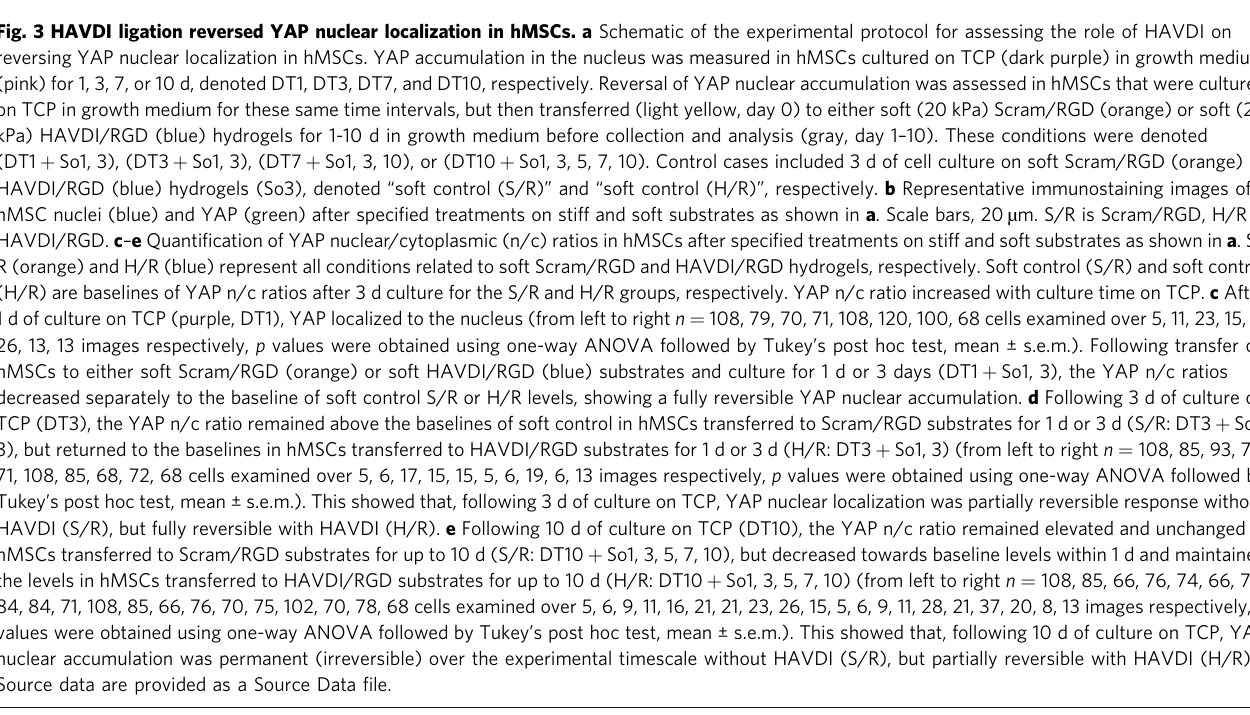
(cid:1) E (Fig. 5b). The different k relationships on Scram/RGD on sub and HAVDI/RGD hydrogels resulted in double sigmoidal relation- ships between F and E (Fig. 5c). The stiffness threshold for trac sub elevating traction force was thus higher on HAVDI/RGD substrates than on Scram/RGD substrates.